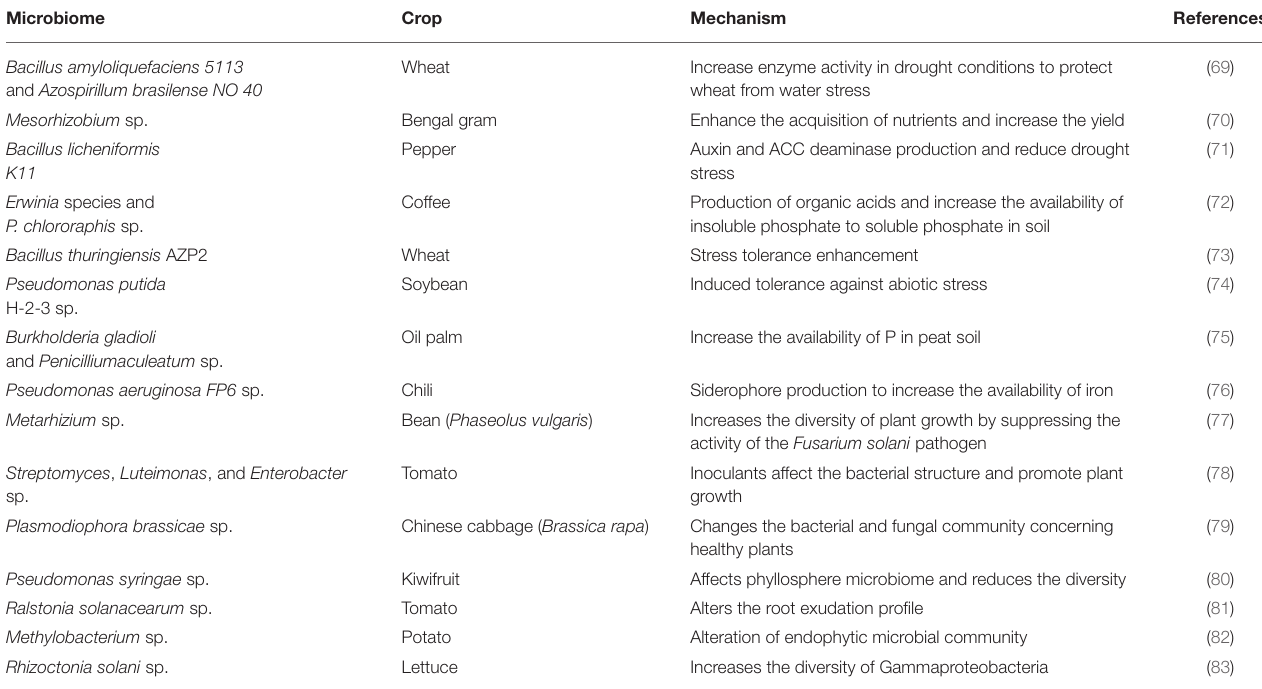
TABLE 1 | Essential contributions of soil microorganisms toward sustainable agriculture in different